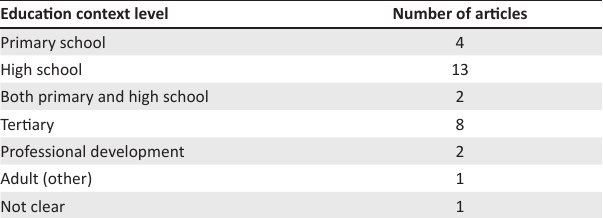
FIGURE 1: Number of papers on language and communication published in Pythagoras per TABLE 1: Number of articles published per education context level. Education context level